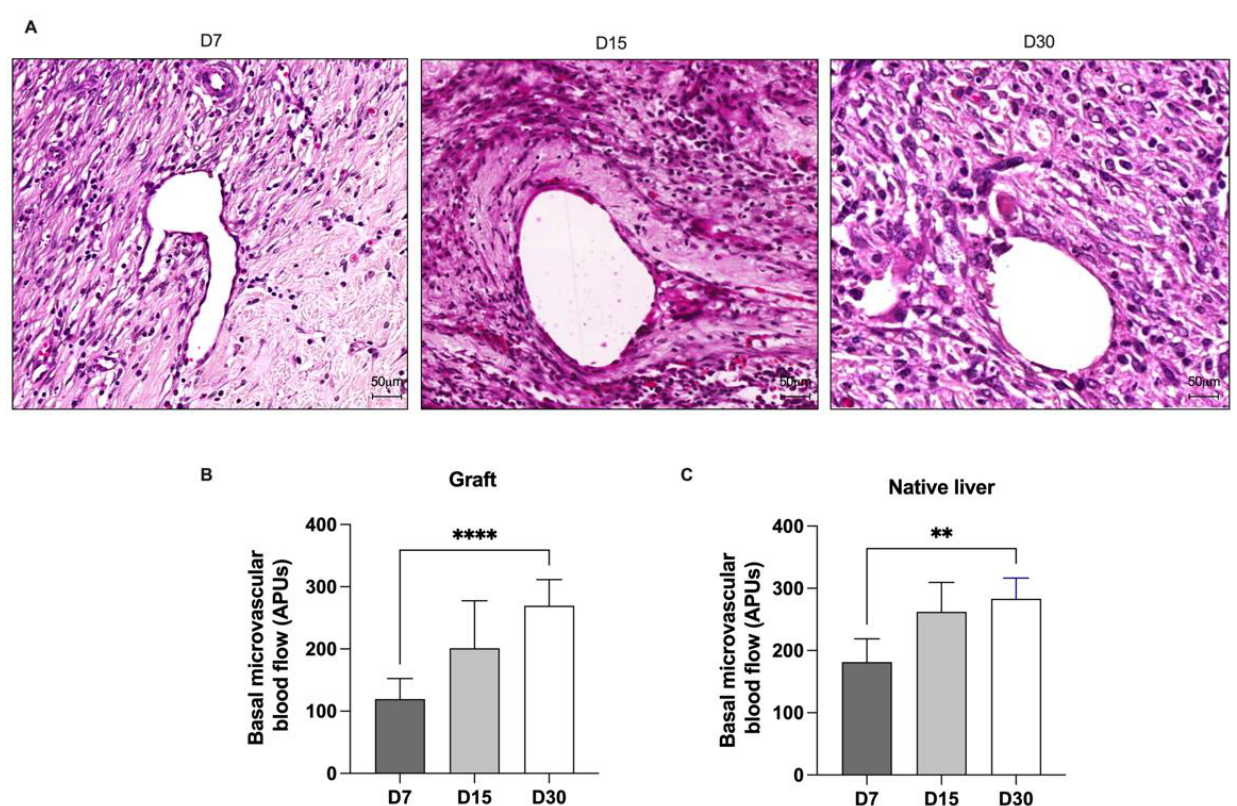
Figure 11. Acellular liver scaffolds promote angiogenesis and sustain blood circulation after transplantation in cirrhotic rats . Histological sections stained with H&E showed blood vessel structures 7, 15, and 30 days post-transplantation ( A ). Measurement of basal microvascular blood flow in the graft ( B ) and cirrhotic liver ( C ). Significant differences were assessed by using Student’s t -test analysis (** p < 0.05, **** p < 0.0001); D7, n = 6; D15, n = 3; D30, n = 5. Scale bars: 50 µm.